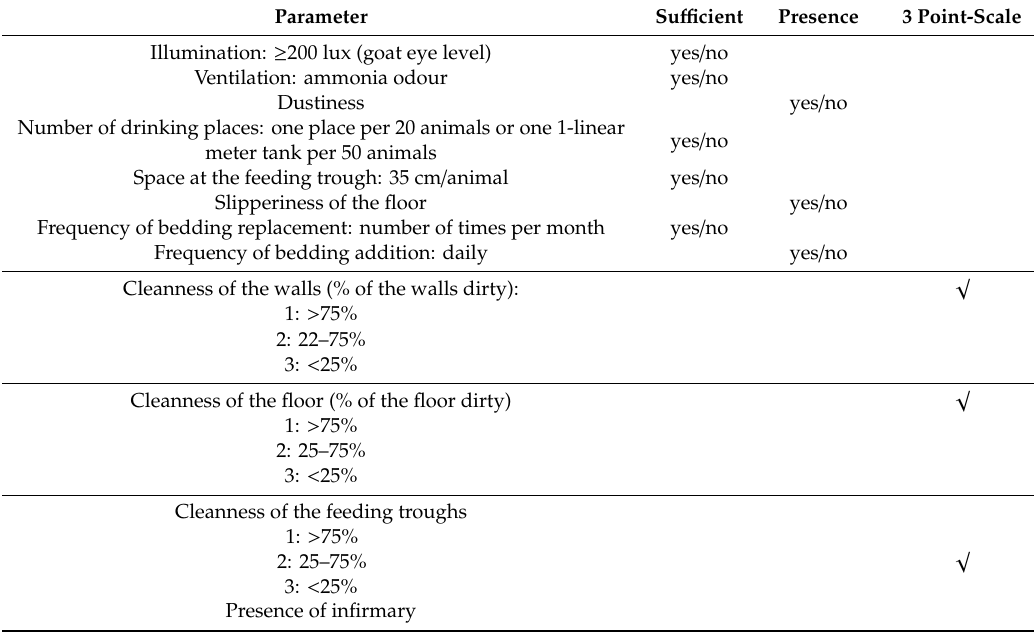
Table A1. Housing and environment parameters identified by the